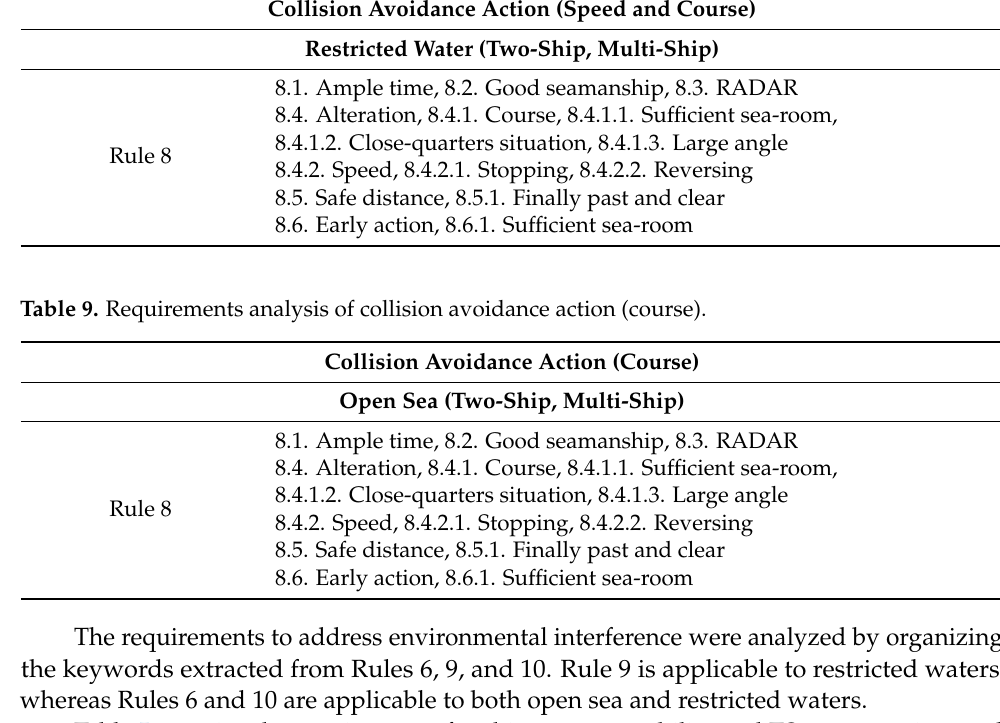
Expert Experience